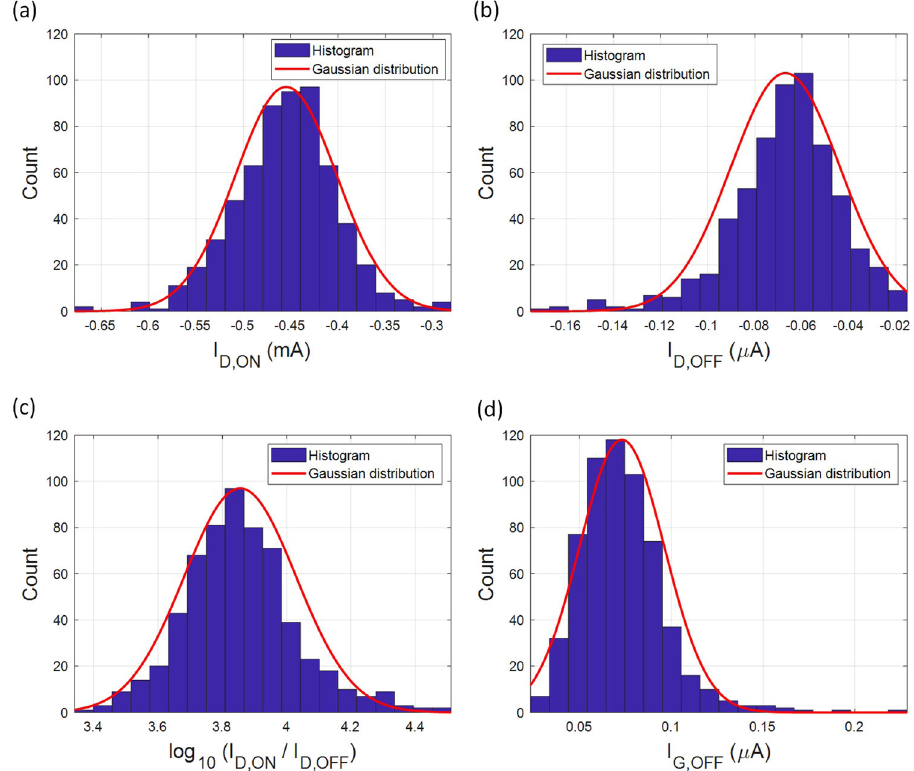
Fig. 4 Histogram of the overall behavior of 600 Small OECTs. a and b show the ON and OFF current distributions, c shows the distribution of the ON/OFF current ratio, d shows the distribution of the gate current in the OFF